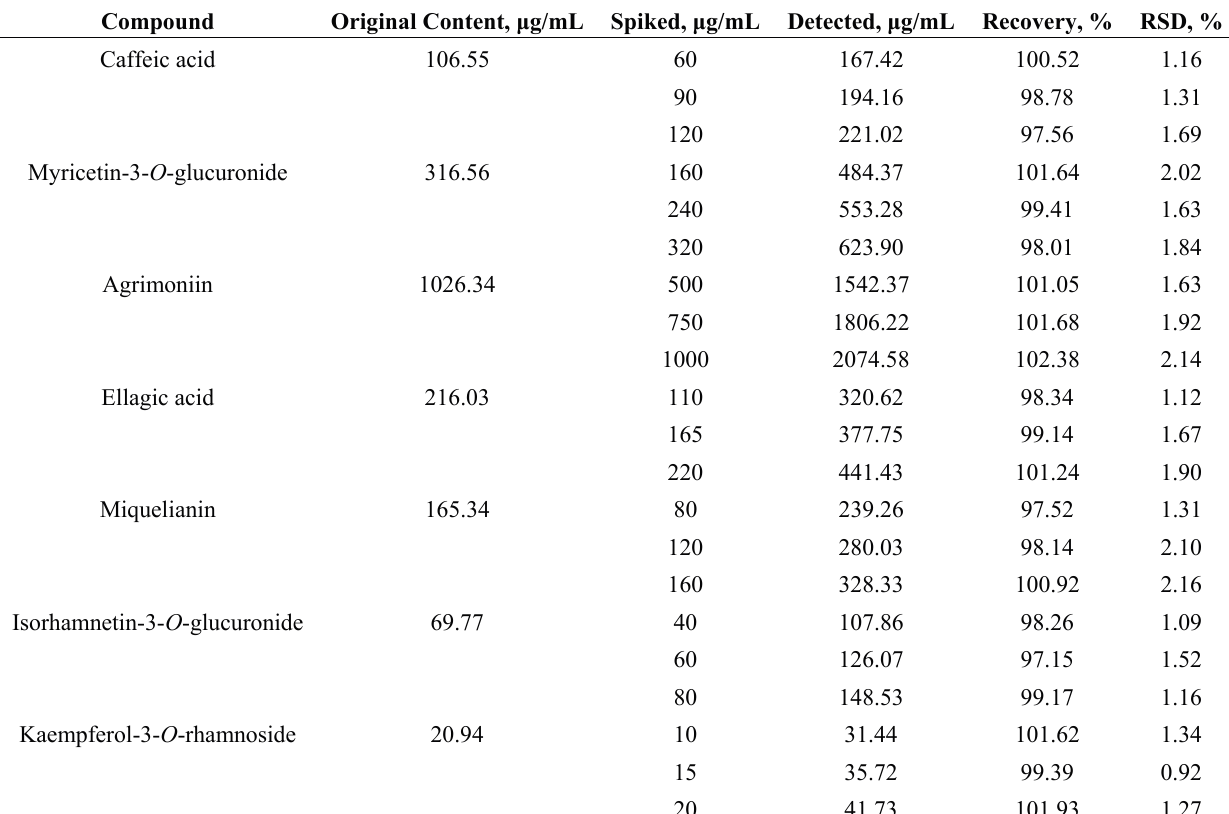
Table 4. Recoveries of seven compounds in P. anserina